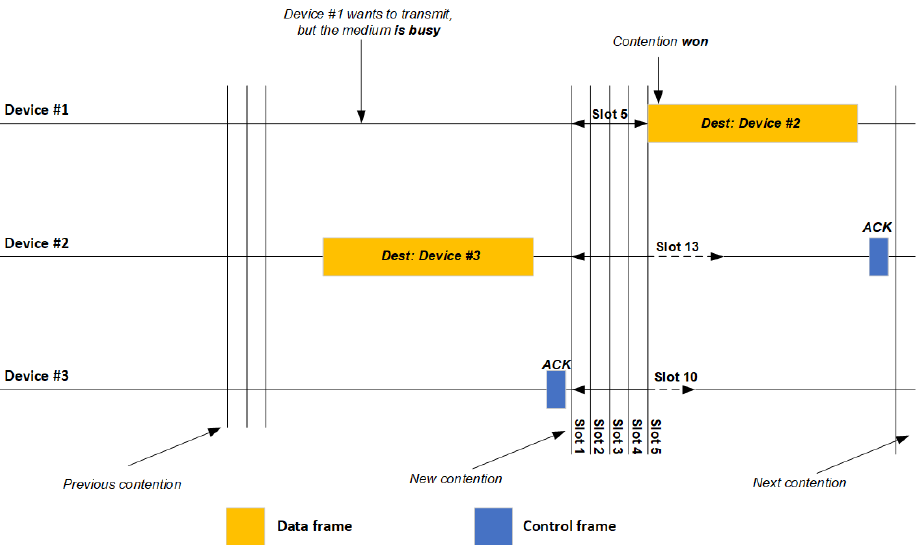
Figure 1. Illustration of Carrier Sense Multiple Access with Collision Avoidance (CSMA/CA) involving three devices on one channel of an IEEE 802.11 network without interference. ACK, Acknowledgment Control Frame; Dest, Destination.